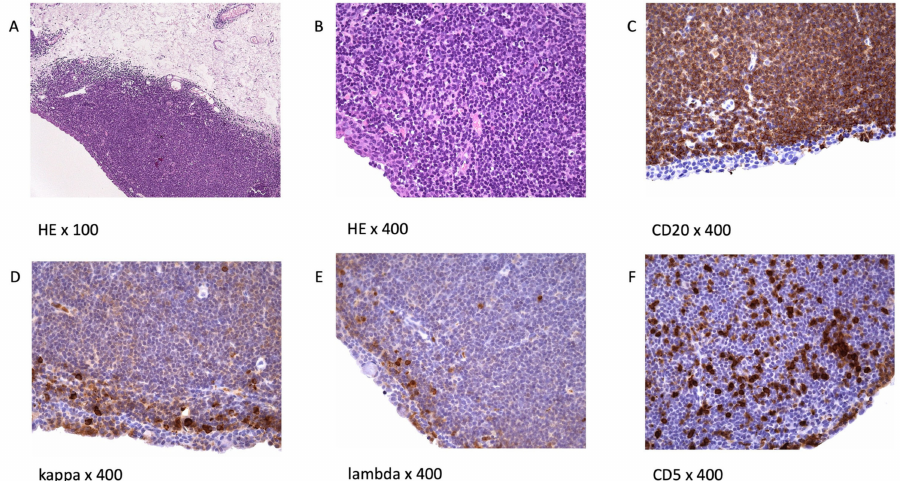
Figure 1. Histology and immunophenotype of OAMZL: ( A ) immunohistochemistry (Hematoxylin and Eosin, H&E staining) of conjunctival lymphoma; ( B ) enlarged view of an H&E staining, demon- strating a dense infiltrate of small, round-shaped cells; ( C ) the lymphoma cells express CD20; ( D , E ) in this case, no clear overexpression of one light chain is observed; ( F ) CD5 staining. Tumor cells are negative; the intermingled CD5 + cells represent T